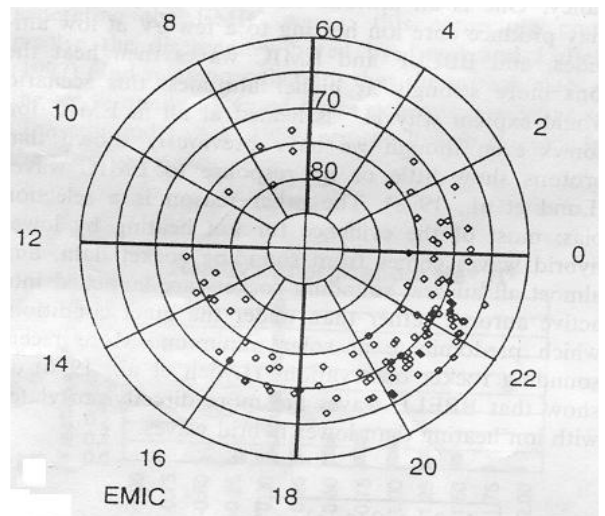
Fig. 2. Distribution of ion conic events over invariant latitude and magnetic local time: EMIC events (Lund et al., 2000).